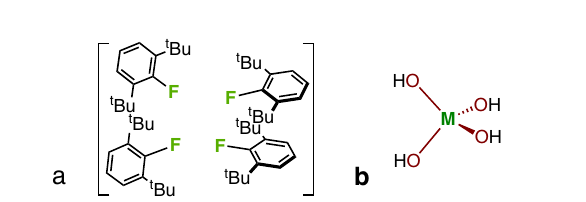
Fig. 7 | The two model systems used to explain the origin of the trends in M(OAr) 4 geometry with pressure. a [FAr] 4 used to understand the in fl uence of inter-ligand repulsion. This system ensures a simple closed shell singlet electronic structure, isoelectronic with [(OAr) 4 ] 4 − and with similar electronegativity, avoiding the complicating effects associated with substantial negative electronic charge. b [M(OH) 4 ] to understand the energy contribution from the MO 4 core.